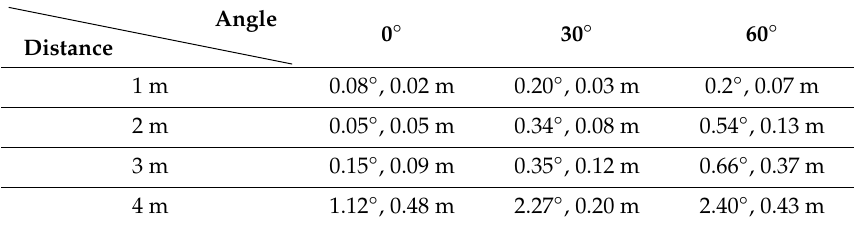
Table 2. Standard deviations of the distance and angle